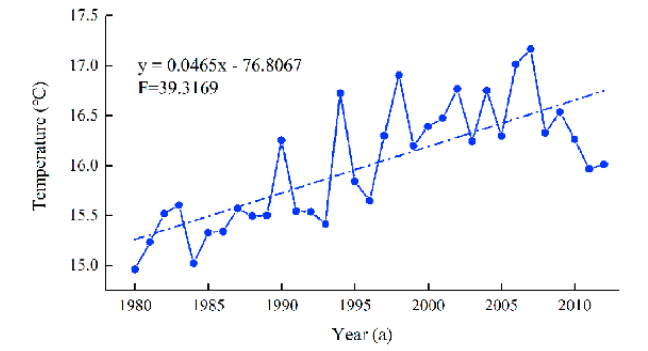
Figure 5. The trend of temperature during the period of 1980 to 2012.